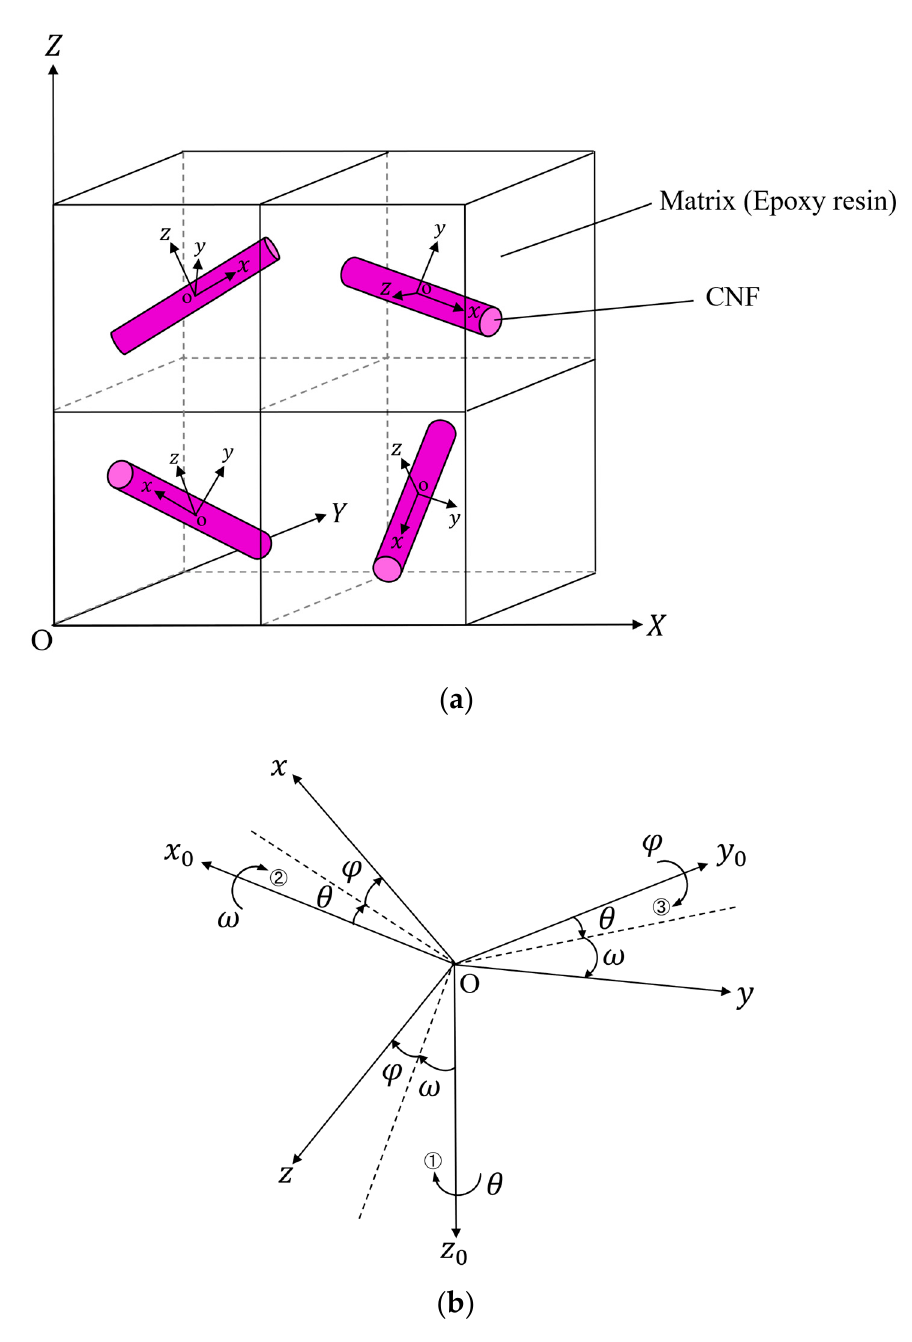
Figure 2. Image of ( a ) the polymer composite with randomly oriented CNF in the FEA and ( b ) the rotation of coordinates.